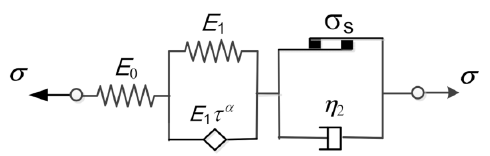
Figure 2. Fractional derivative viscoelastic-plastic